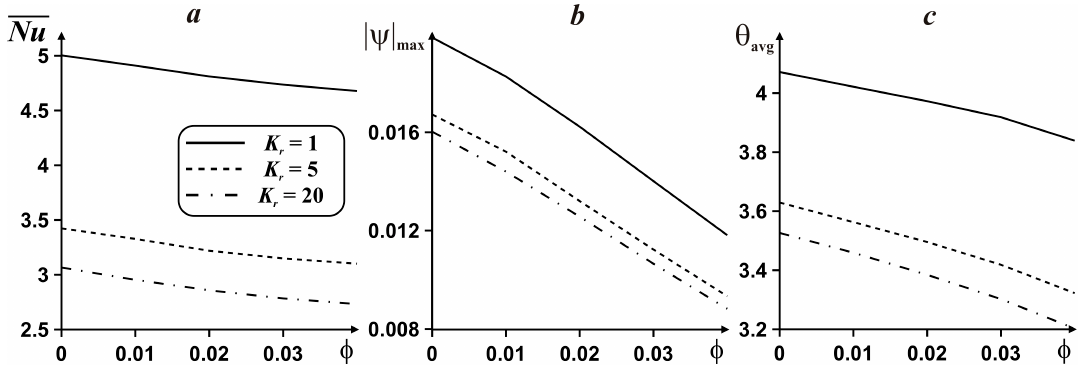
Figure 6. Dependences of the average Nusselt number ( a ), nanoliquid circulation rate ( b ) and mean heater temperature ( c ) on φ and K r for Ra = 10 3 , δ = 0.2.